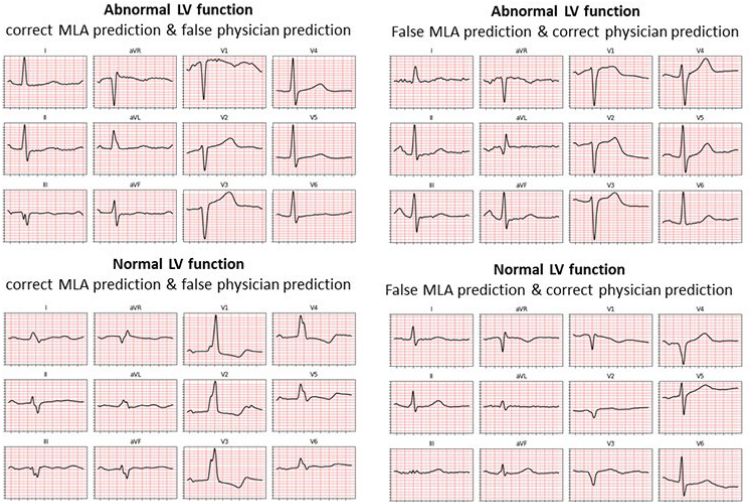
Figure 3. ECG examples of discordant diagnosis of normal/abnormal left ventricular systolic dys- function by physicians and machine learning algorithm.